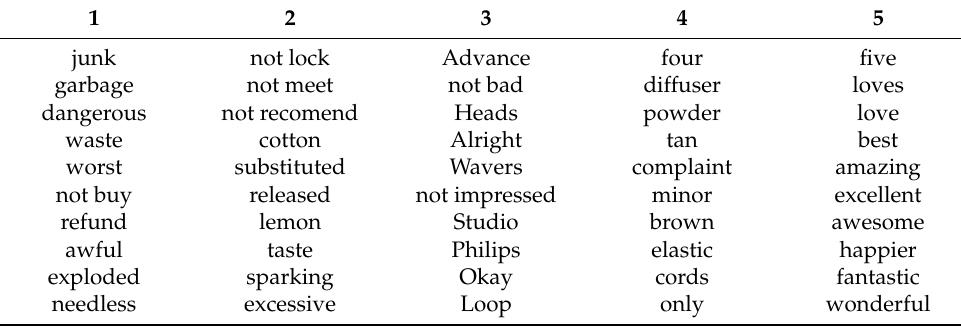
Table 5. Top 10 feature terms related to each star (hair